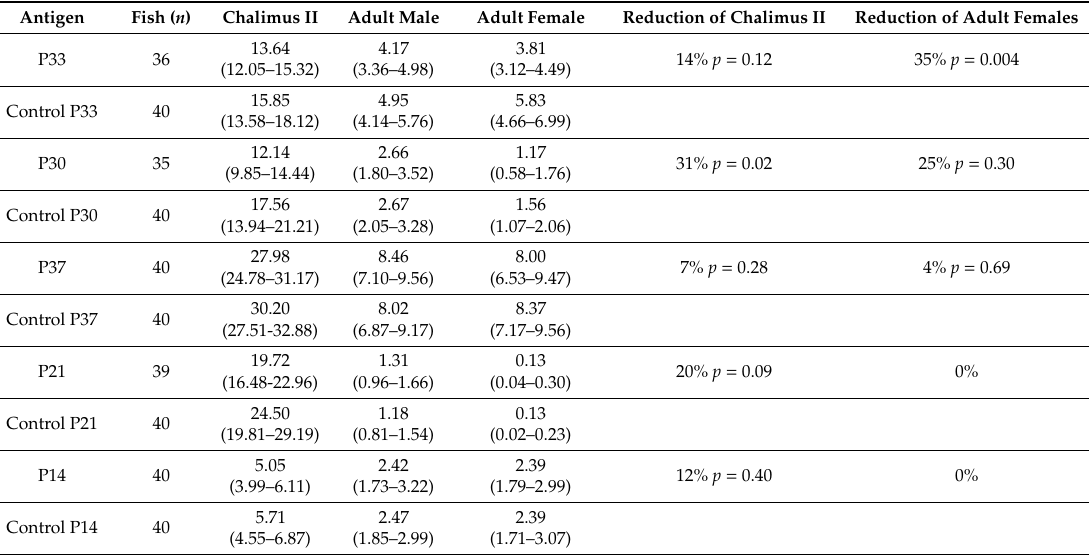
Figure 4. Antibody response in vaccinated fish. ( A ) The recombinant proteins were produced in E. coli and analyzed by polyacrylamide gel electrophoresis (PAGE) and Western blot (WB). Ten micrograms of recombinant proteins was loaded onto a 12% SDS-polyacrylamide gel and stained with Coomassie Brilliant Blue or transferred to a nitrocellulose membrane. For Western blot analysis, pooled sera collected from vaccinated salmons before salmon louse infestation at approximately week 10 post-initial vaccination were used as primary antibodies. The membrane was then incubated with mouse anti-rainbow trout antibodies and revealed with a goat anti-mouse IgG-HPR conjugate. ( B ) Antibody titers were determined in vaccinated and control fish by ELISA. Values of D.D. at 450 nm in vaccinated and control groups were compared by Student’s t -test with Welch’s correction for unequal variances ( p = 0.05). Table 2. E ff ect of vaccination on sea lice infestations in the common tank